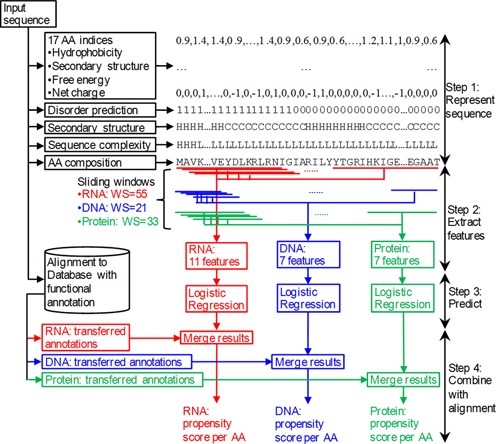
Architecture of DisoRDPbind.